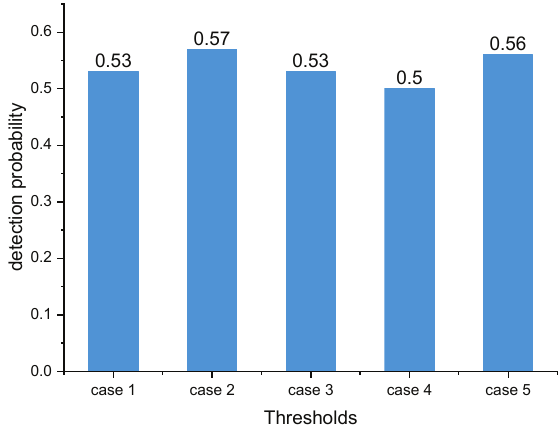
Figure 5. Detection probability of SAGC at different initial